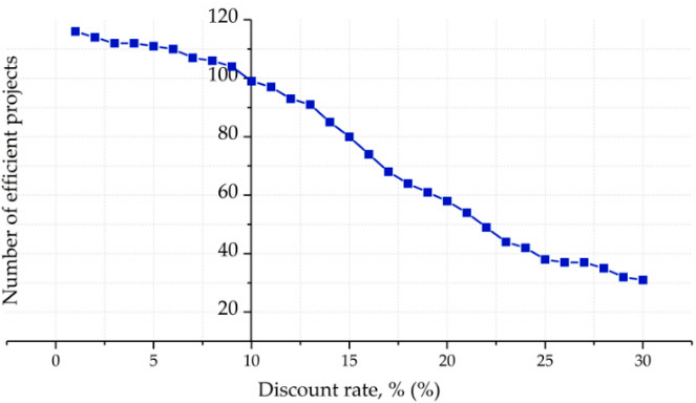
Figure 8. The relationship between the discount rate and the total number of efficient projects.